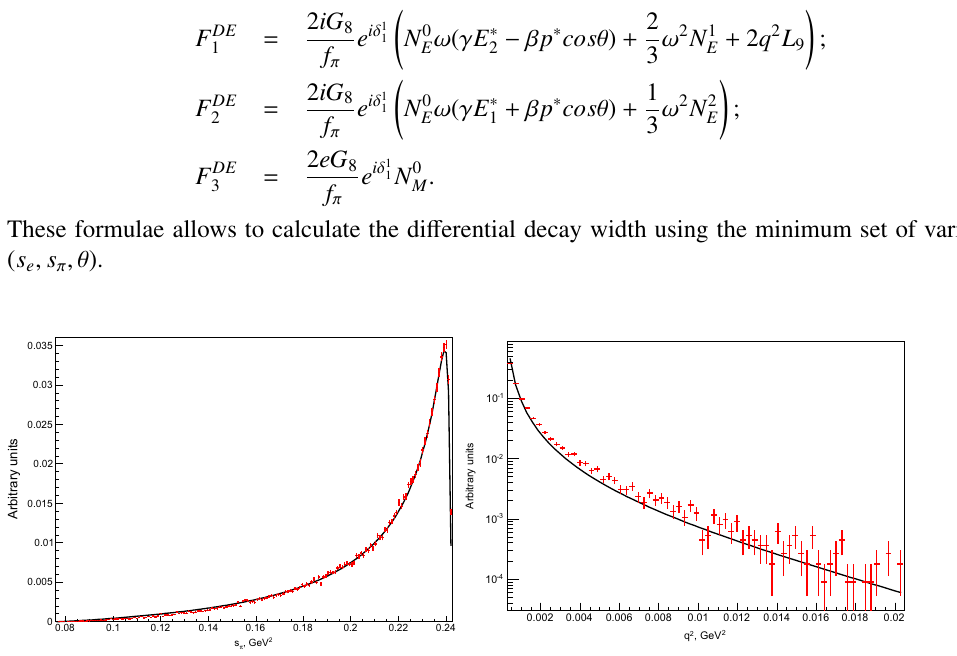
Figure 1. Comparison between the full di ff erential decay width with respect to invariants q 2 and s π calculated by our approach (solid line) and with the Monte Carlo generator (dots are given with their statistical